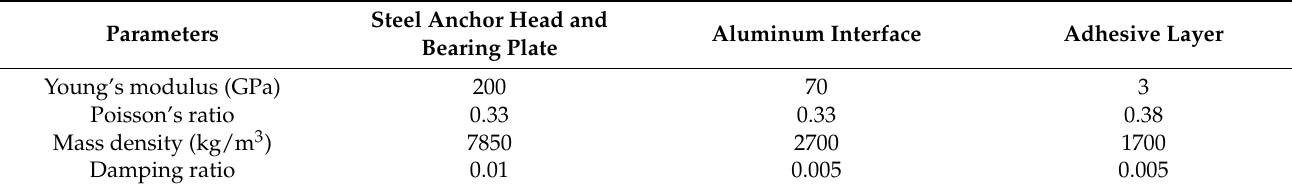
Table 1. Mechanical properties of the aluminum interface and the steel anchorage.